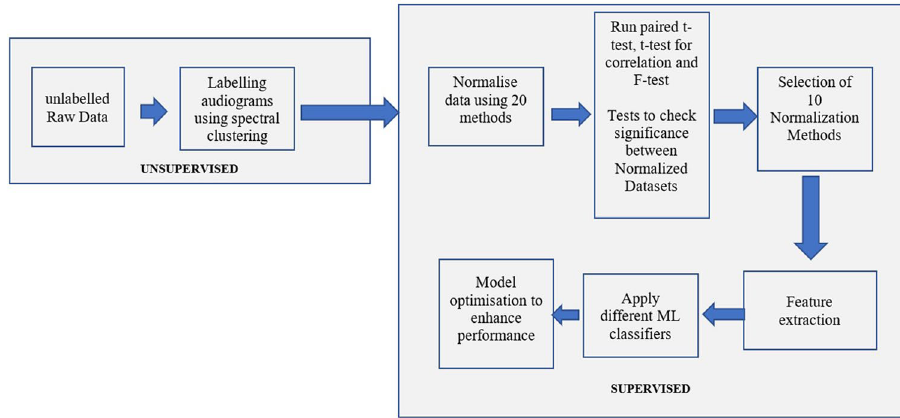
Figure 3. Stages to build the ML model.